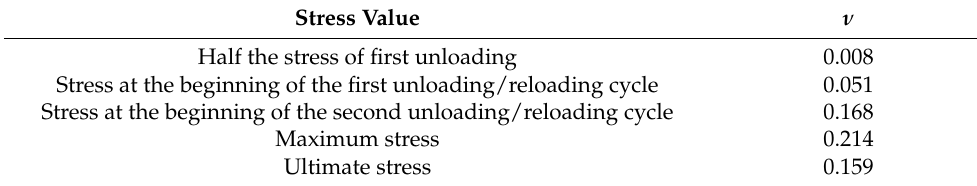
Table 4. Some of the values assumed by the coefficient ν during the test. Stress Value ν Half the stress of first unloading 0.008 Stress at the beginning of the first unloading/reloading cycle 0.051 Stress at the beginning of the second unloading/reloading cycle 0.168 Maximum stress 0.214 Ultimate stress